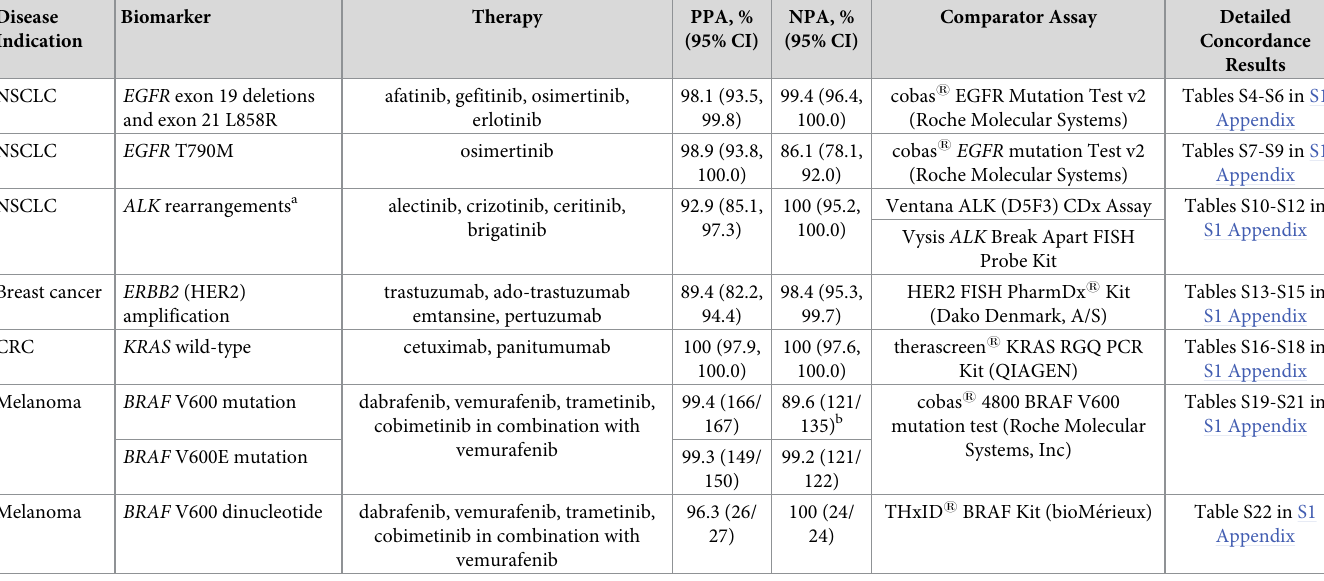
CTA = clinical trial assay; FISH = fluorescence in situ hybridization; NPA = negative percent agreement; PPA = positive percent agreement; PCR = polymerase chain reaction. a Samples evaluated were from a phase 3, multicenter, open-label study (NCT02075840) that evaluated the efficacy and safety of alectinib compared with crizotinib in treatment-na ï ve cancer patients with ALK rearrangements. b The reported difference in NPA values for BRAF V600 and BRAF V600E is likely attributed to known sensitivity differences in the cobas BRAF mutation test, which has lower sensitivity for detection of dinucleotide V600 alterations than for the single nucleotide V600E c.1799T > A alteration, especially for samples in which F1CDx detected the nucleotides to be of lower than 40% mutational allele frequency, leading to low NPA